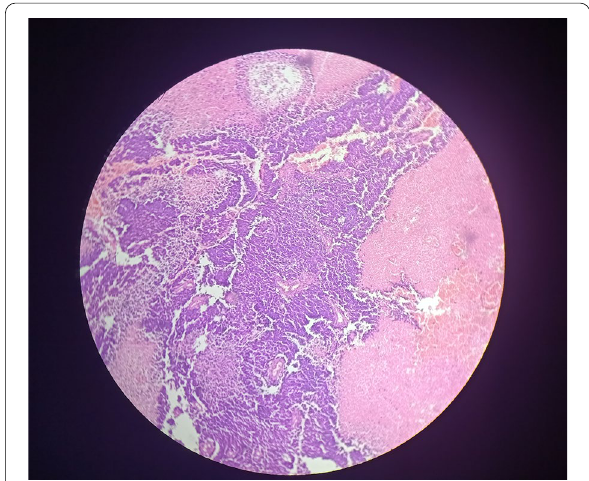
Fig. 2 Solid nests and organoid